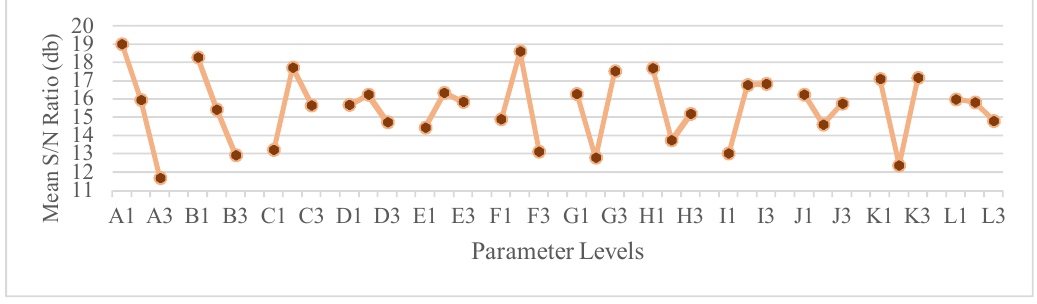
Figure 4. Mean signal-to-noise ratio curves for bead width.